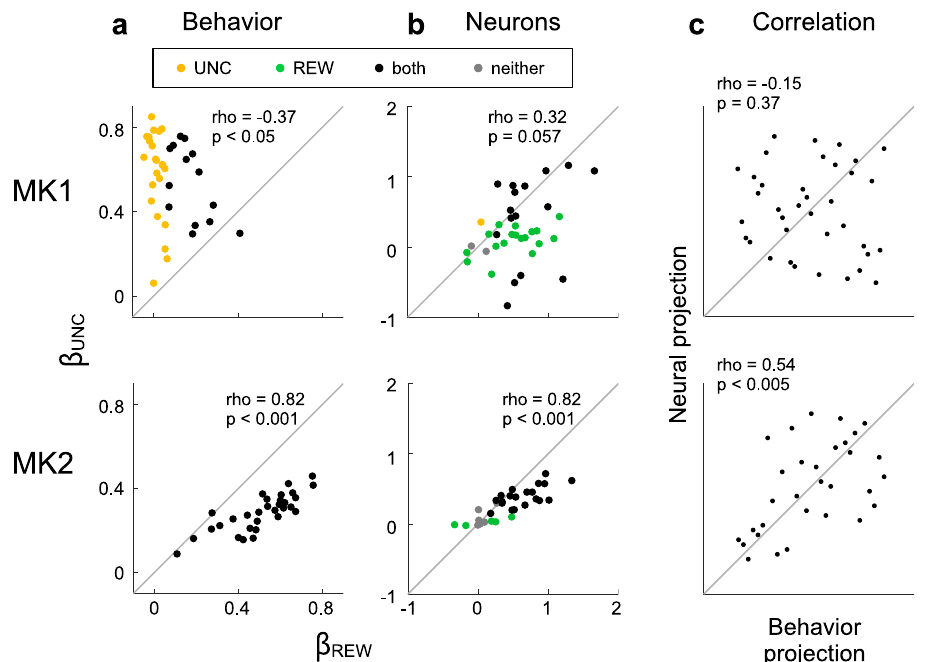
β REW_neural fi t from average z-scored fi ring rates during the 400ms after the mask appeared inside the RF of individual neurons. Conventions are the same as a . c Scatter points show the rank of PC projections (see text for details) of neural (ordinate) and behavior (abscissa) data. The gray line is the unity line. Rho and p - value areof a Spearmancorrelation analysis. Source dataare providedasaSource Data fi